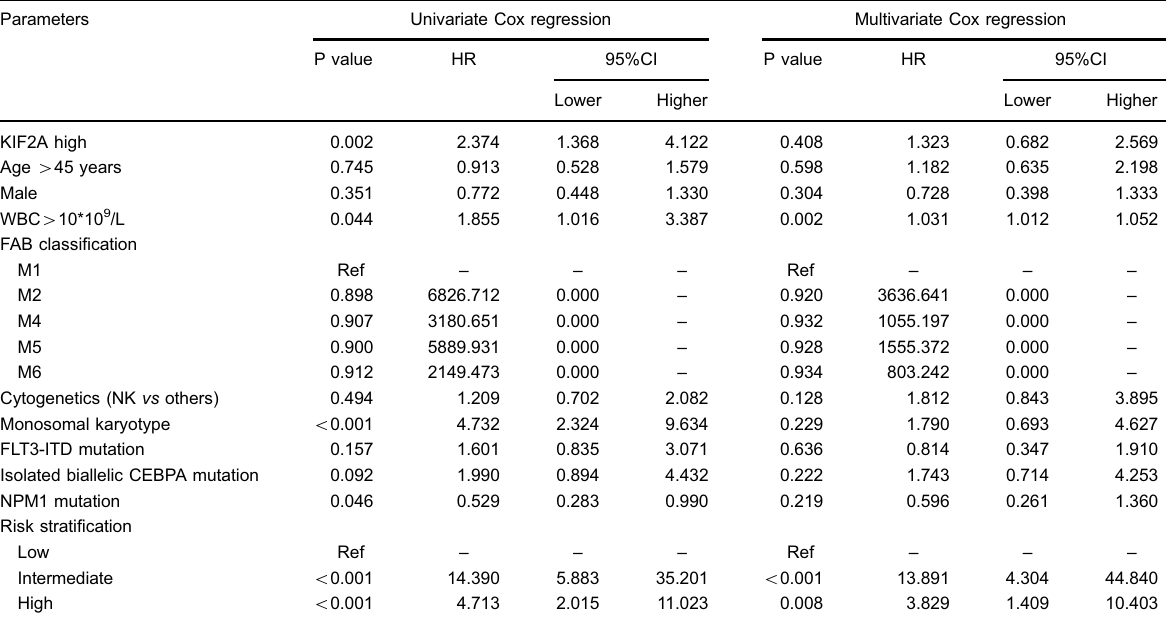
Table 4. Factors affecting overall survival by Cox proportional hazards regression model analyses.